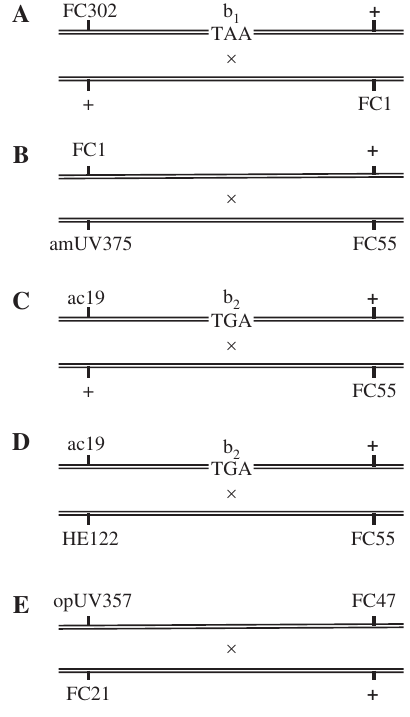
Figure 5 Examples of crosses used to separate measuring of fre- quencies of reciprocal